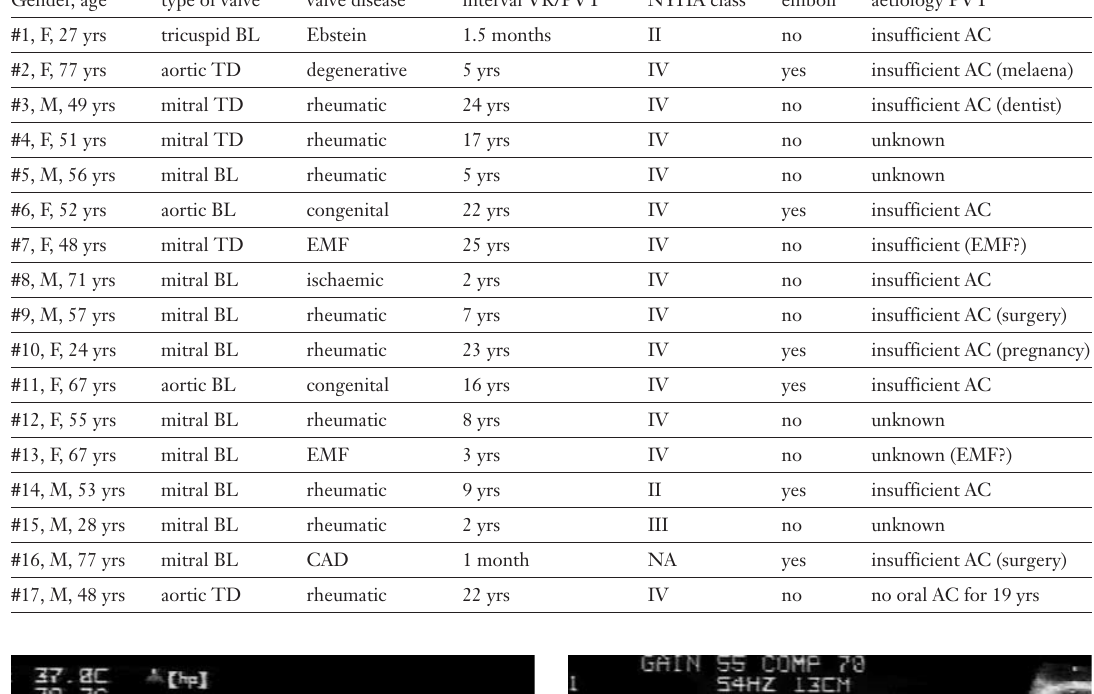
a. Transoesophageal echocardiography (longitudinal view), patient #2 after bileaflet aortic valve replacement. 3 thrombi are visible: 2 above (arrow) und 1 beneath the pros- thetic aortic valve (dashed arrow). b. M-mode echocar- diography through the aortic prosthesis shows no closure of the aortic valve (arrow) which is stuck due to the thrombi, resulting in severe aortic regurgitation. LA = left atrium